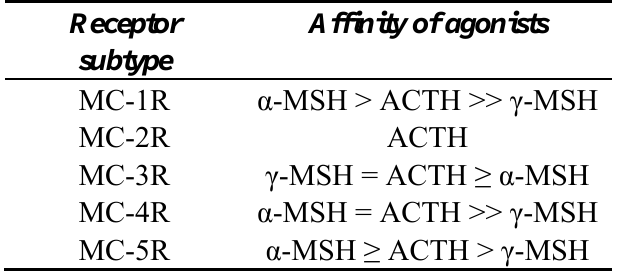
Table 1. Melanocortin receptor subtypes and affinity of their ligands [3,4].